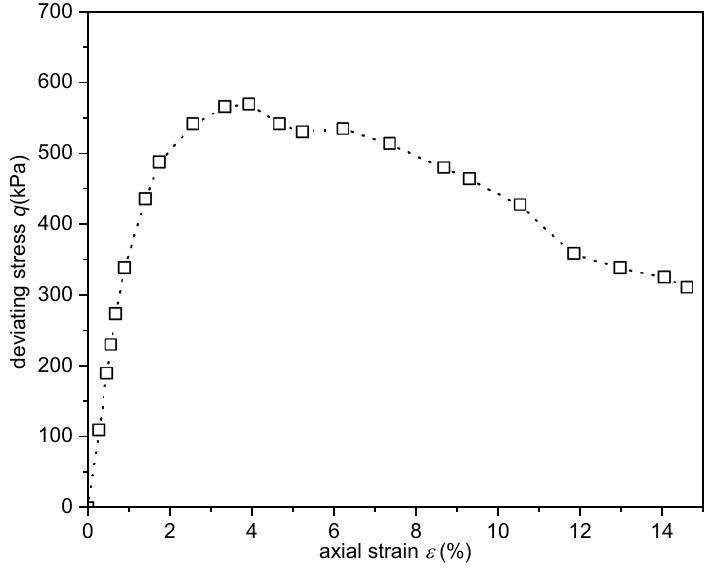
Figure 5. 100 kPa undisturbed stress – strain curve.